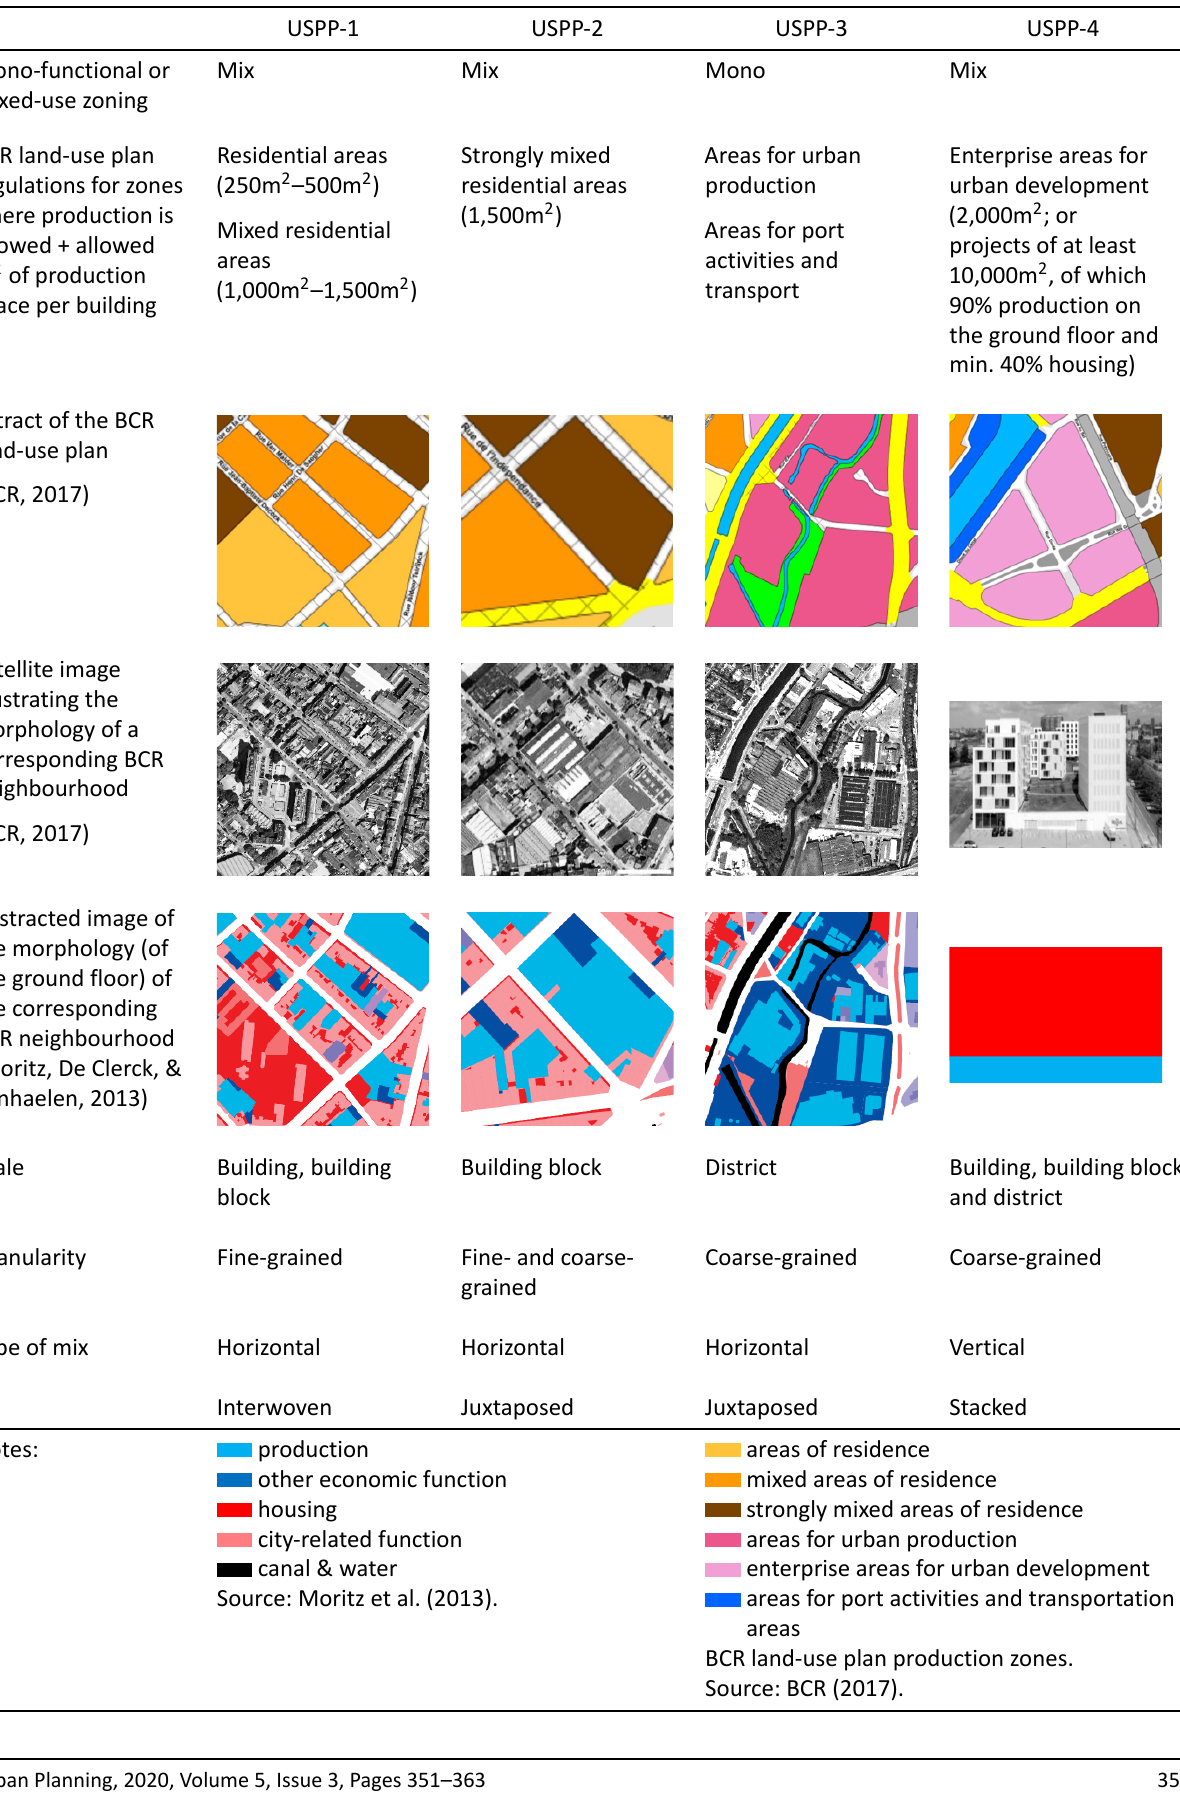
Table 1. Typology of